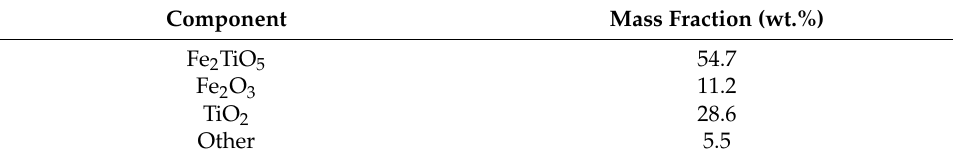
Table 8. Composition of the ilmenite oxygen carrier given by Condori et al. [5].